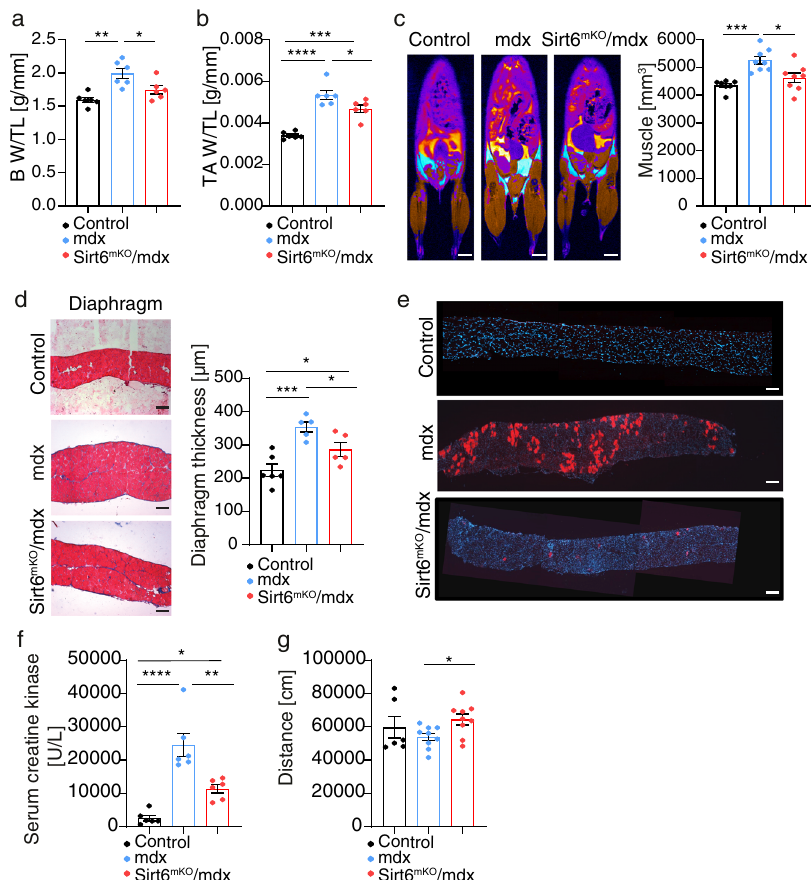
Fig. 3 Absence of Sirt6 improves membrane integrity of dystrophic muscle fi bers. a Body weight/tibia length ratios of control, mdx and Sirt6 mKO /mdx mice (one-way ANOVA with Bonferroni multiple comparisons test: * p = 0.0354, ** p = 0.001, n = 6 for each group). b TA muscle weight/tibia length ratios of control, mdx and Sirt6 mKO /mdx mice (one-way ANOVA with Bonferroni multiple comparisons test: * p = 0.0388, *** p = 0.002, **** p < 0.0001, n = 6 for each group). c MRI analysis of muscle and fat mass of 12-week-old control ( n = 7), mdx ( n = 8) and Sirt6 mKO /mdx ( n = 8) littermates. Scale bar: 5 mm. Quanti fi cation of muscle volume are shown on the right (one-way ANOVA with Bonferroni multiple comparisons test: * p = 0.0108, *** p = 0.0006). d Masson ’ s trichrome staining of the diaphragm muscle in control ( n = 6), mdx ( n = 5) and Sirt6 mKO /mdx ( n = 5) mice (one-way ANOVA with Benjamini and Yekuteili multiple comparisons test: * p = 0.0263, * p = 0.0320, *** p = 0.0002). Scale bar: 100 μ m. e Evans blue staining of diaphragm muscles from control, mdx and Sirt6 mKO /mdx mice ( n = 4 for each group). Cross-sectional images of decreased myo fi ber leakage in Sirt6 mKO /mdx mice are shown. Scale bar: 100 μ m. f Serum creatine kinase (CK) enzyme activity in control, mdx and Sirt6 mKO /mdx mice (one-way ANOVA with Bonferroni multiple comparisons metabolic cages (PhenoMaster) (one-way ANOVA with Benjamini and Yekuteili multiple comparisons test: * p = 0.0486). Twelve to 16 weeks old male mice were used. Data are presented as mean ± SEM ( a – d , f , g ). Source data are provided in the Source Data fi